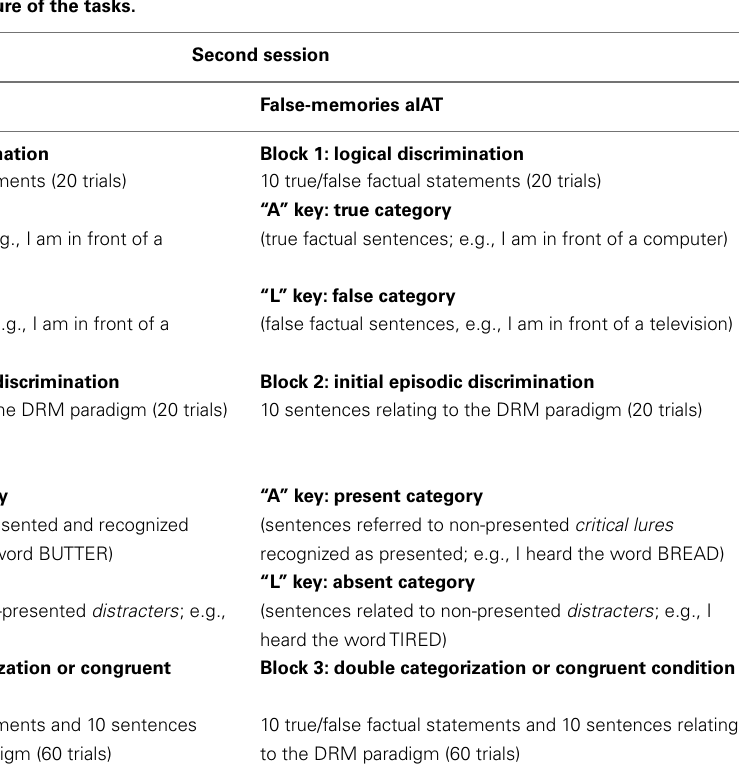
Table 1 | Scheme of the experimental paradigm and structure of the